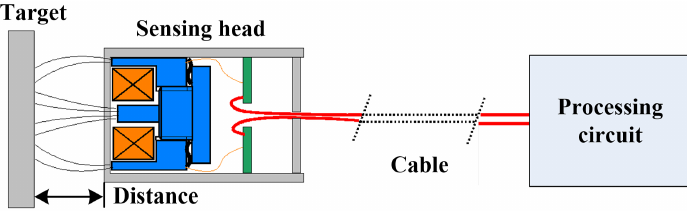
Figure 1. The schematic diagram of inductive proximity sensors.